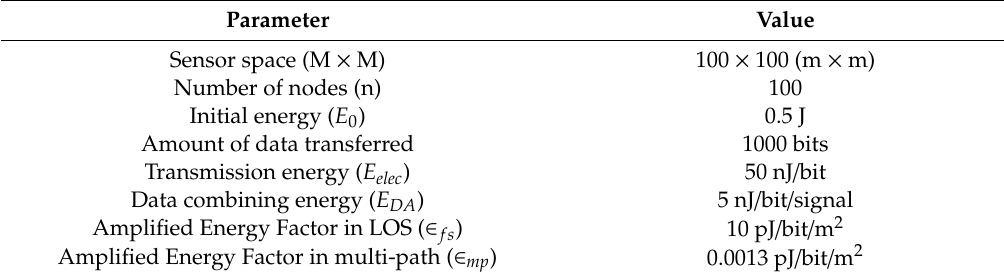
Table 4. Experimental parameters.